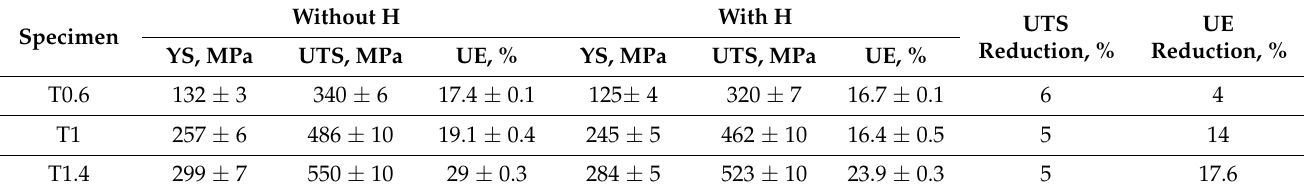
Figure 4. ( a ) Engineering stress–strain curves for AM 316L-SS with lattice structure and different thicknesses: with and without H charging; ( b ) graphical representation of UTS and UE% before and after H charging. Table 2. Mechanical properties of AM 316L-SS with different thicknesses before and after H